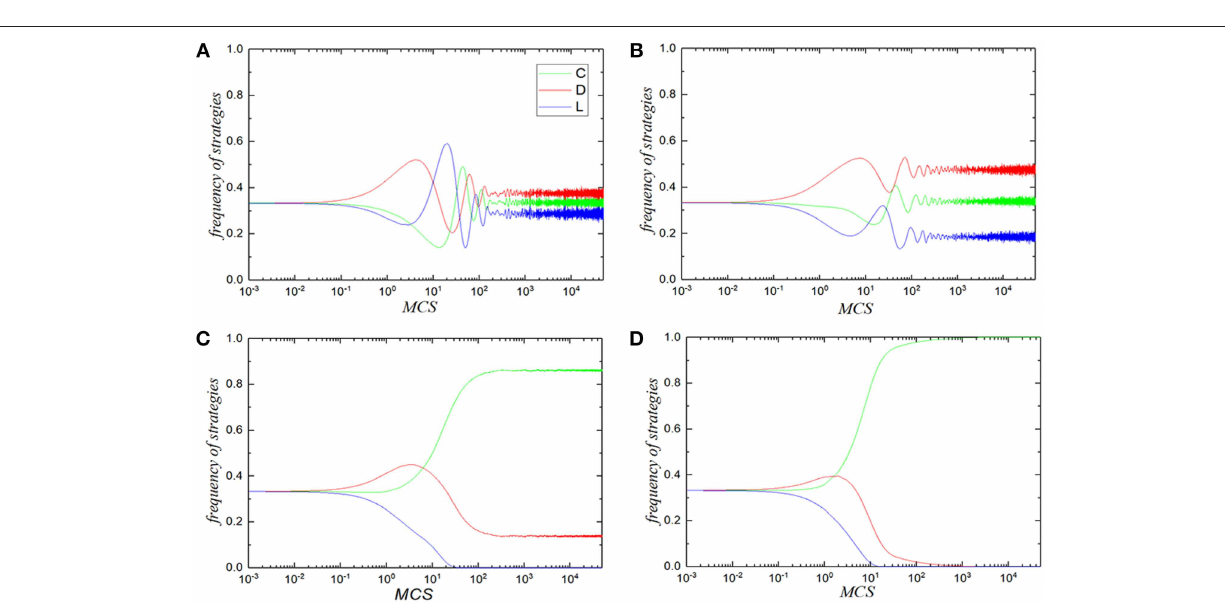
FIGURE 4 | Frequency of three strategies with the spacial structured population at each time step under the specified reciprocal rewarding strength β in the voluntary PDG. Panels (A–D) correspond to β = 0.0 (traditional situation), β = 0.2, β = 0.3, β = 0.5, respectively. In all panels, green, red and blue curves correspond to cooperators, defectors, and loners, respectively. In all simulations, Other parameters are set to be L = 100, MCS = 5 × 10 4 , σ = 0.3, b = 1.28, K =